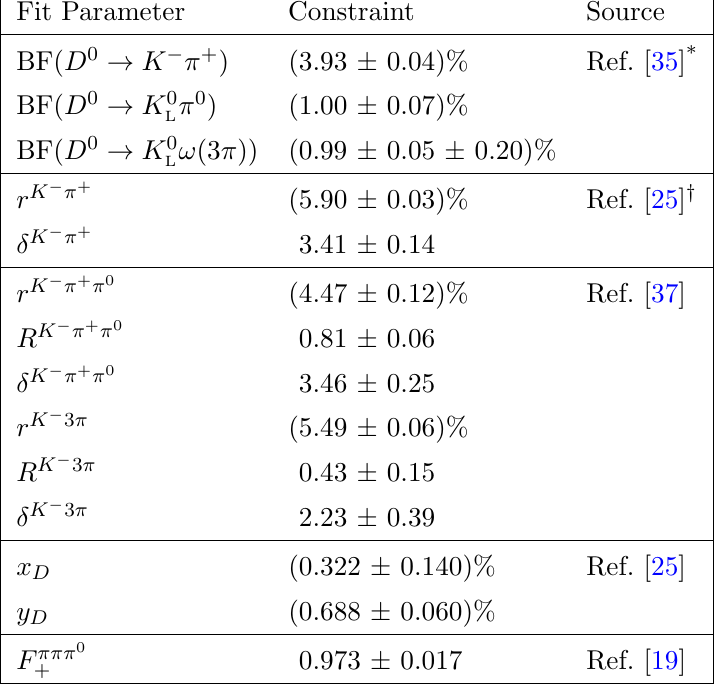
K 0 (cid:25)(cid:25) S